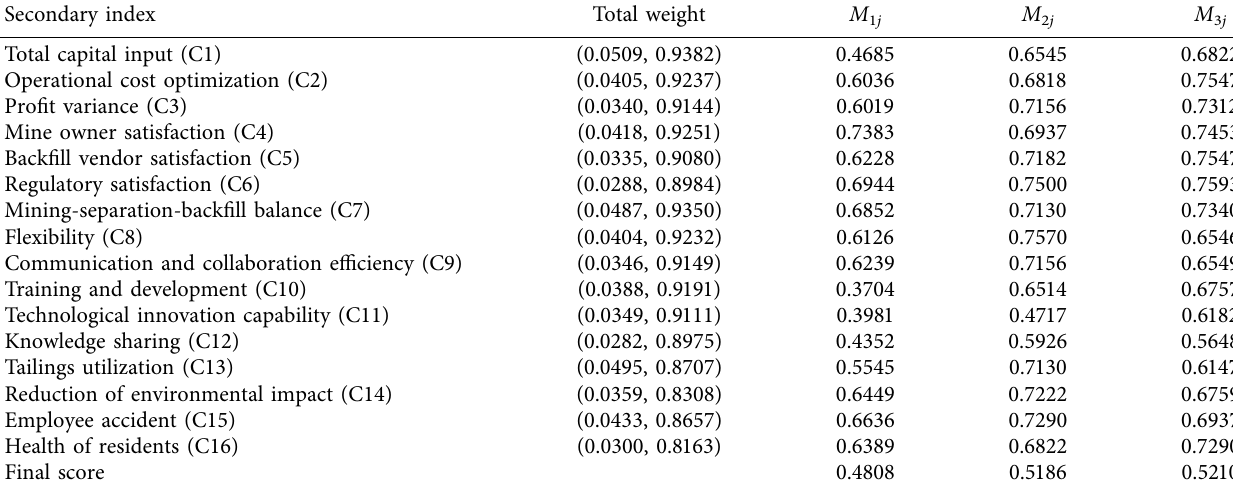
Table 5: Score function of the secondary index on the three backfill operation